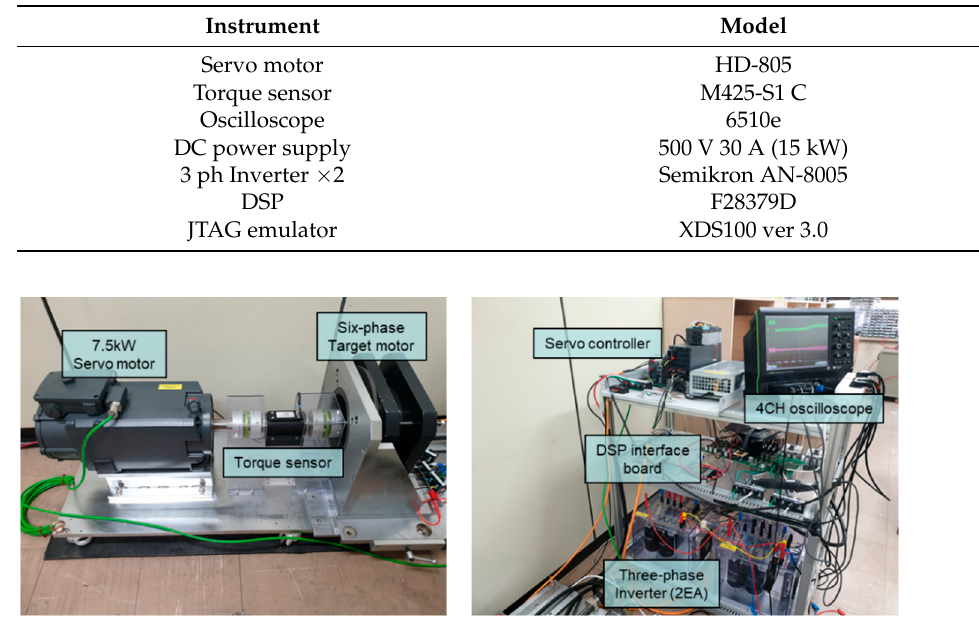
Figure 11. Manufactured motor: ( a ) stator; ( b ) rotor. Table 4. The experimental instruments.